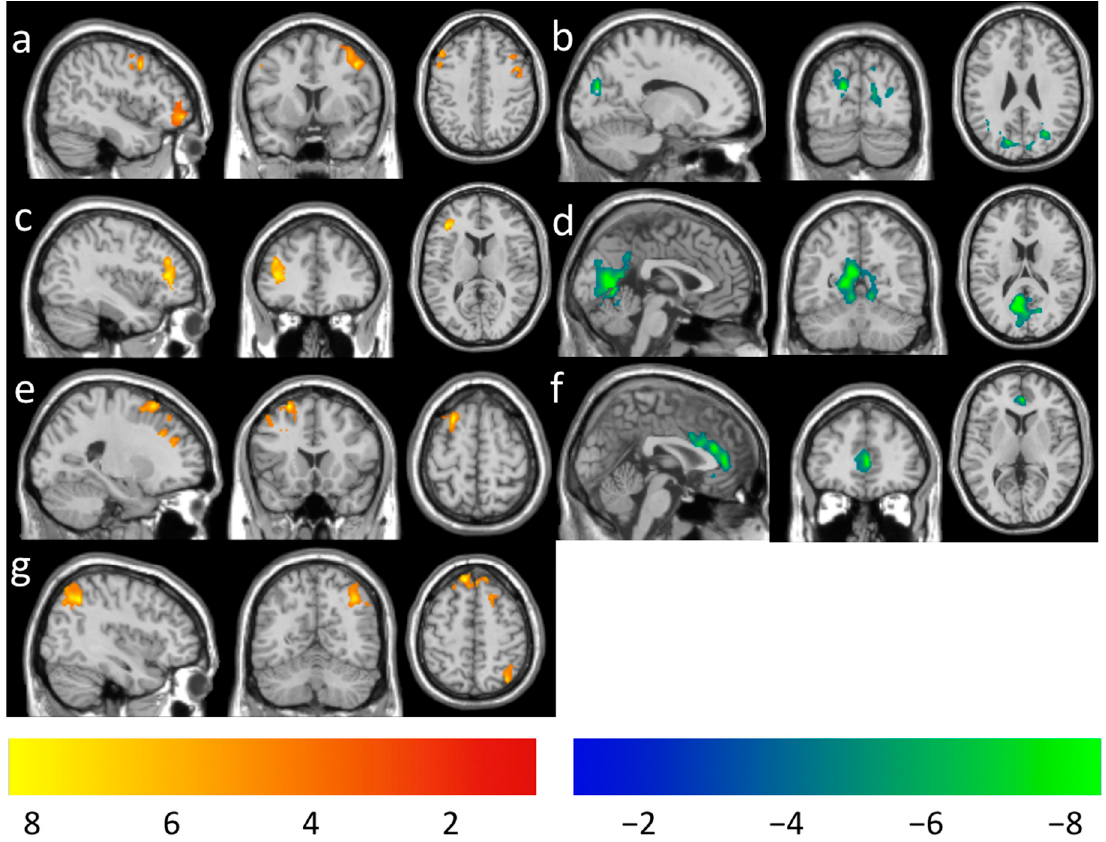
Figure 5. Regions overlaid on a standard brain template in which the meditation practice time was positively associated with functional connectivity with a seed ROI at the ( a ) RMT (peak-T 44, 8, 44), ( c ) LSPL (peak-T − 38, 34, 12), and ( e ) RFE (peak-T 24, 18, 60), ( g ) LFE (peak-T 40, − 56, 46) and negatively associated with functional connectivity with a seed ROI at the ( b ) RMT (peak-T 8, − 68, 22), ( d ) LSPL (peak-T − 2, − 64, 4), and ( f ) RFE (peak-T 0, 32, 24) at the thresholds of a voxel-level p -value of 0.005 and corrected cluster-level p -value of 0.05. The color bar shows the range of t-values.